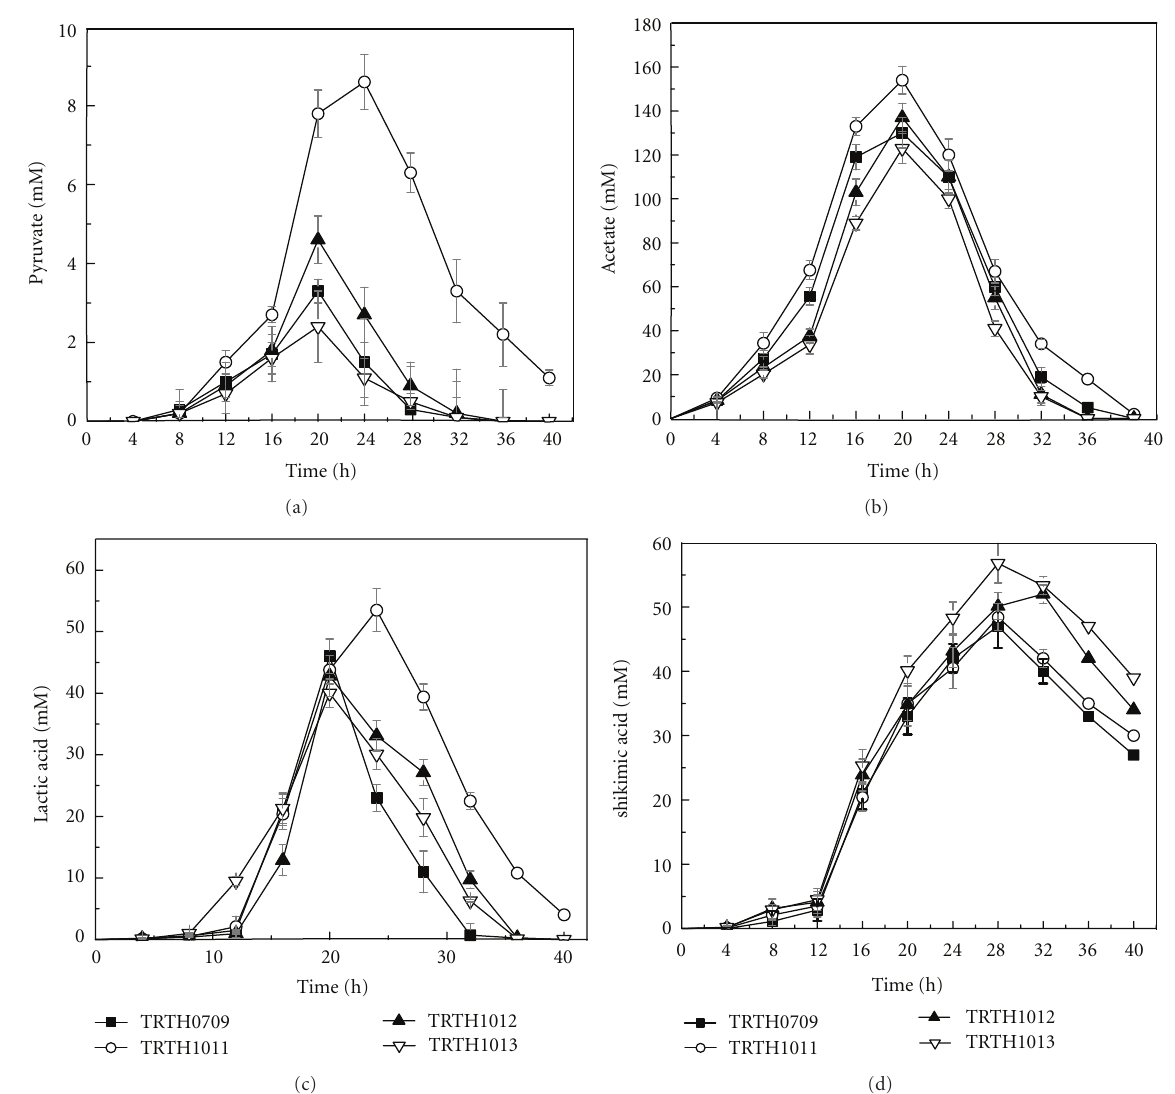
Figure 3: Concentrations of pyruvate, lactic acid, acetate, and shikimic acid in the fed-batch fermentations.